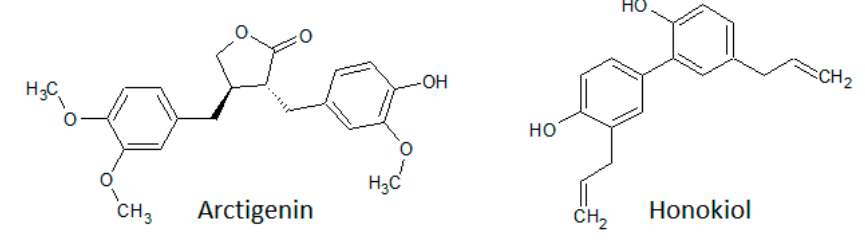
Figure 7. Structures of honokiol and arctigenin.